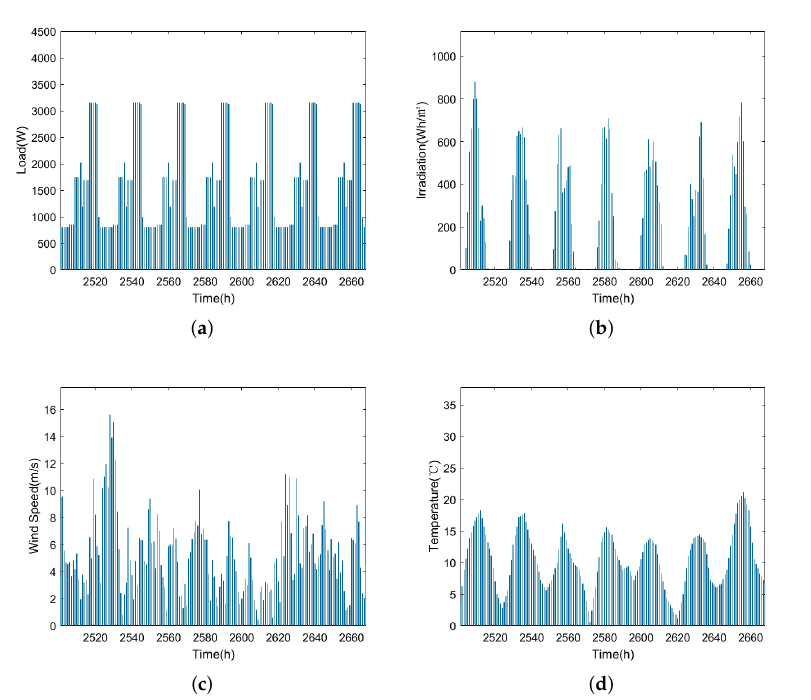
Figure 6. Typical week of normal power consumption. ( a ) Load. ( b ) Solar irradiation. ( c ) Temperature. ( d ) Wind speed.